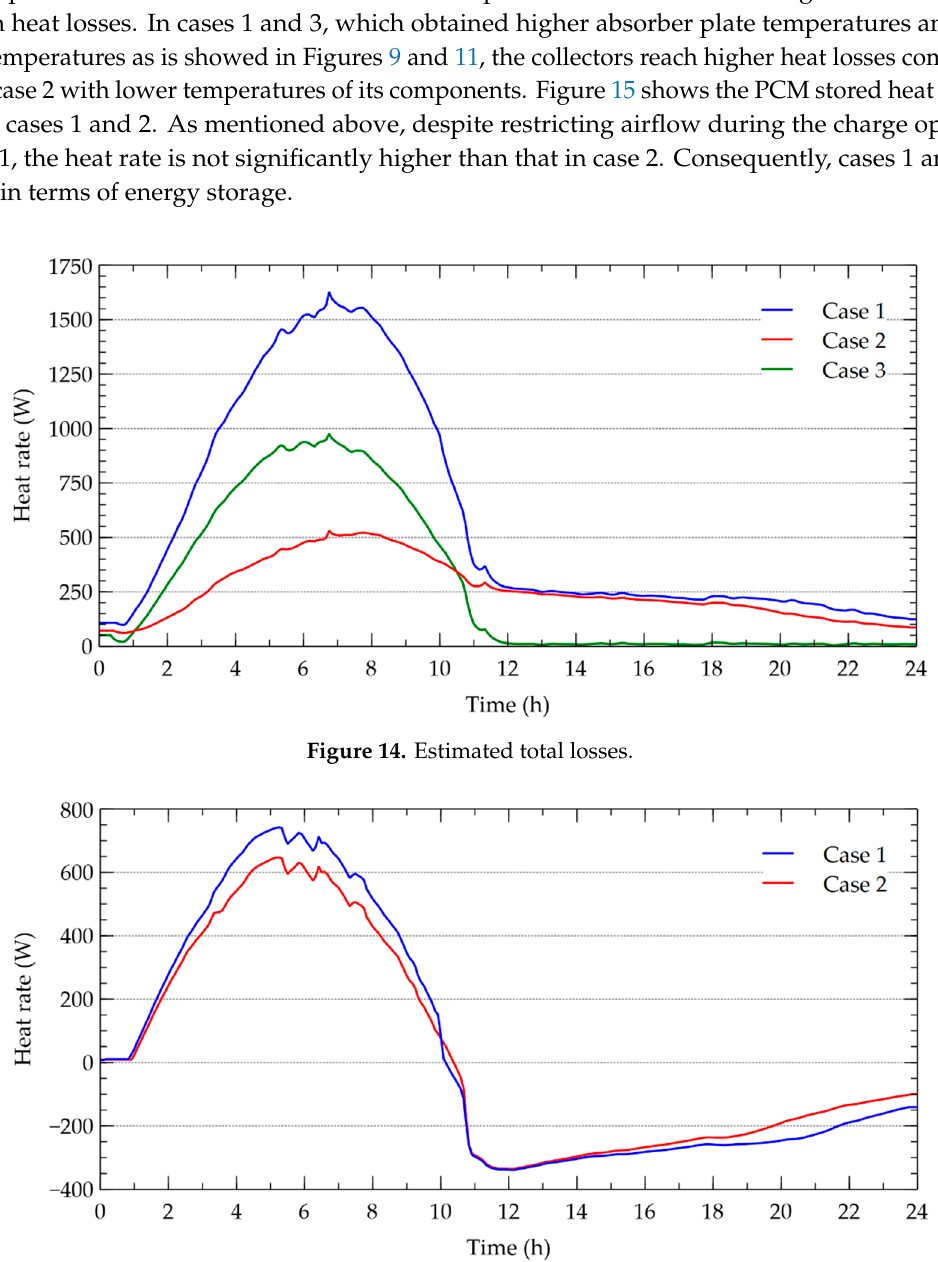
Figure 13. Estimated average outlet temperatures.